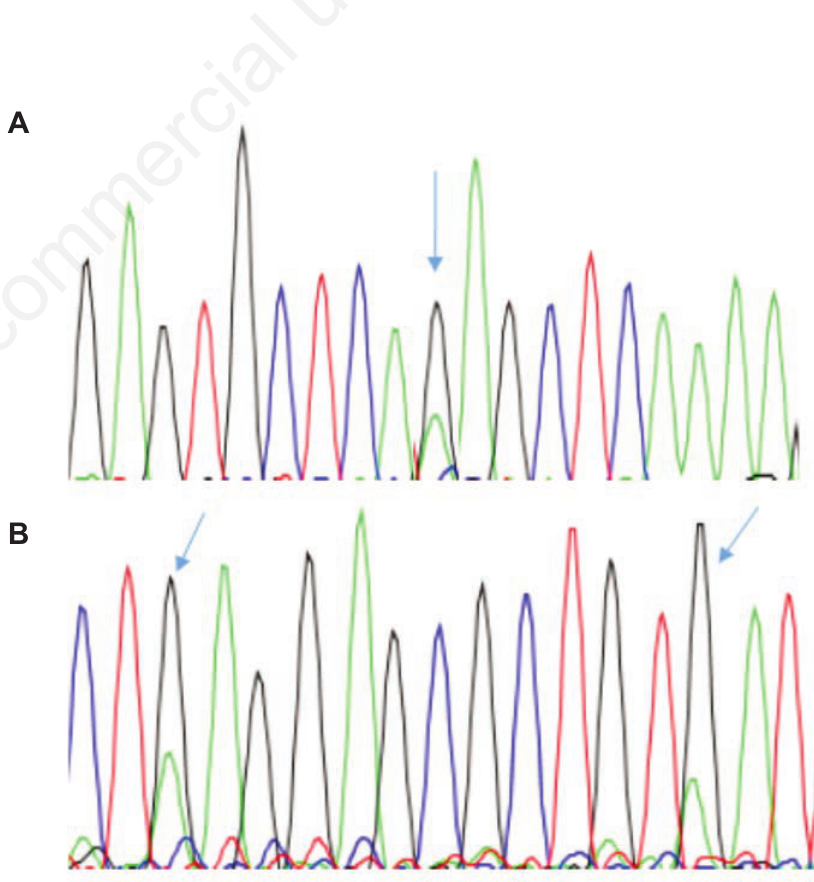
Figure 1. A) Shows the sequence of exon 23 of MYH7 gene with an arrow pointing to rare G to A changes at codon 949. B) Shows a compound heterozygous variants. Arrows point to the identified alterations G to A changes at codon 902 and